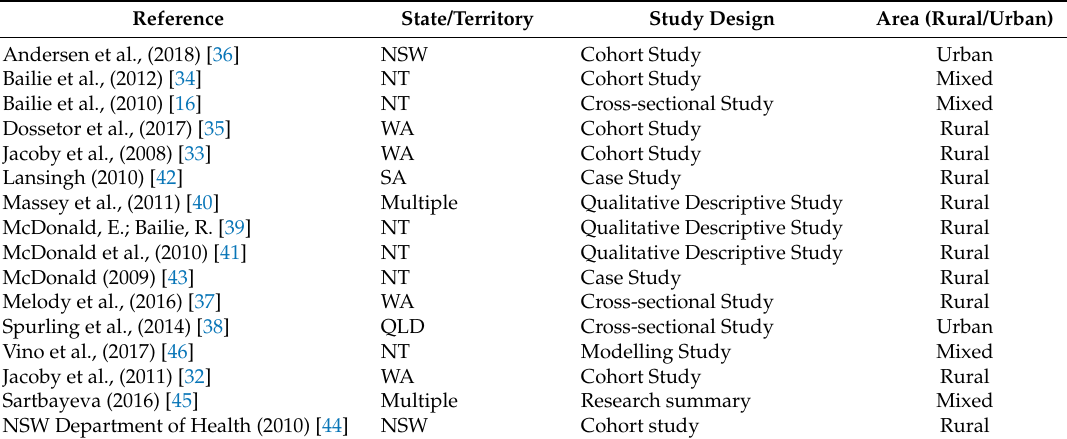
Table 1. Characteristics of studies meeting inclusion